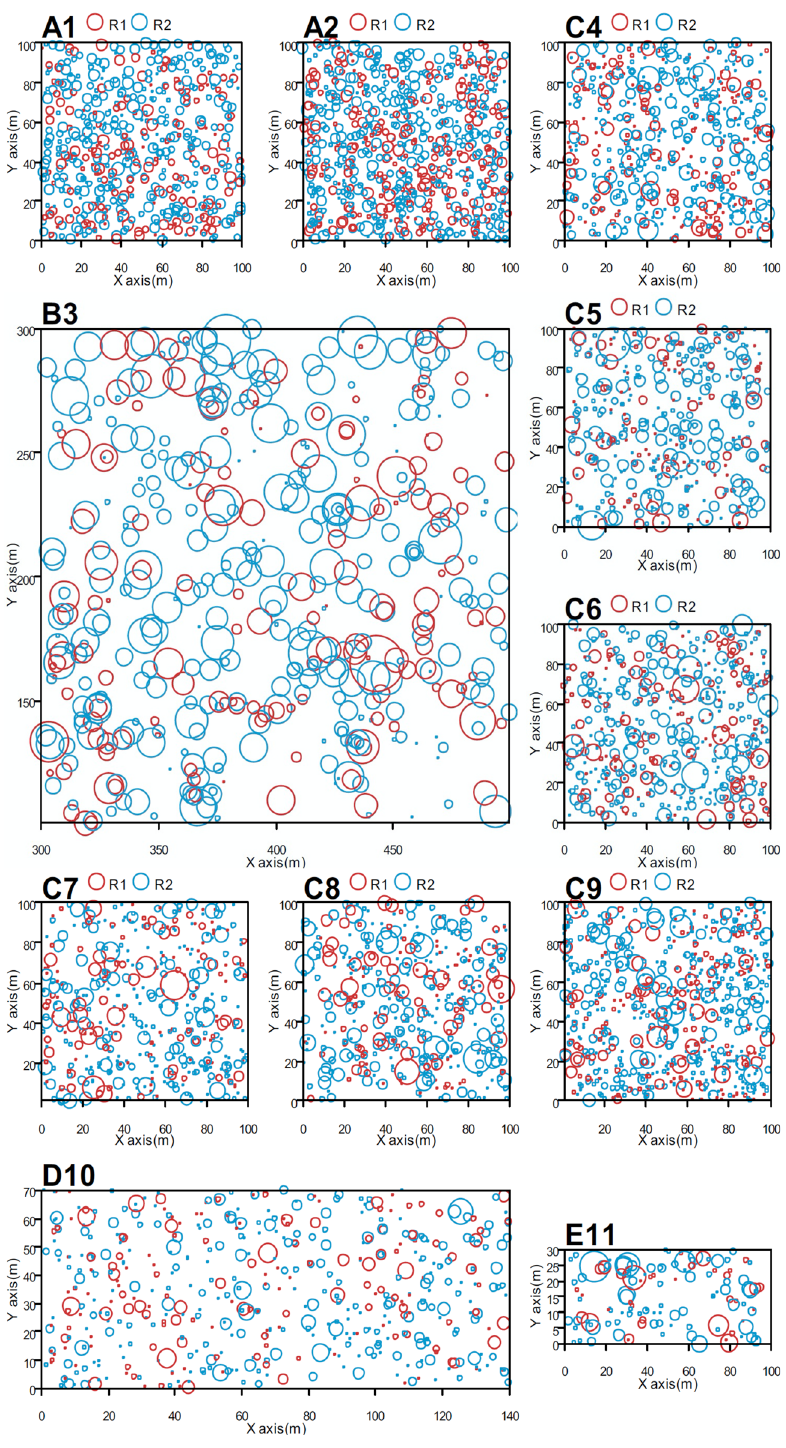
Figure 5. Plot maps with trees classified according to the sub-type structural unit. Clustered and even structural units are not shown in the